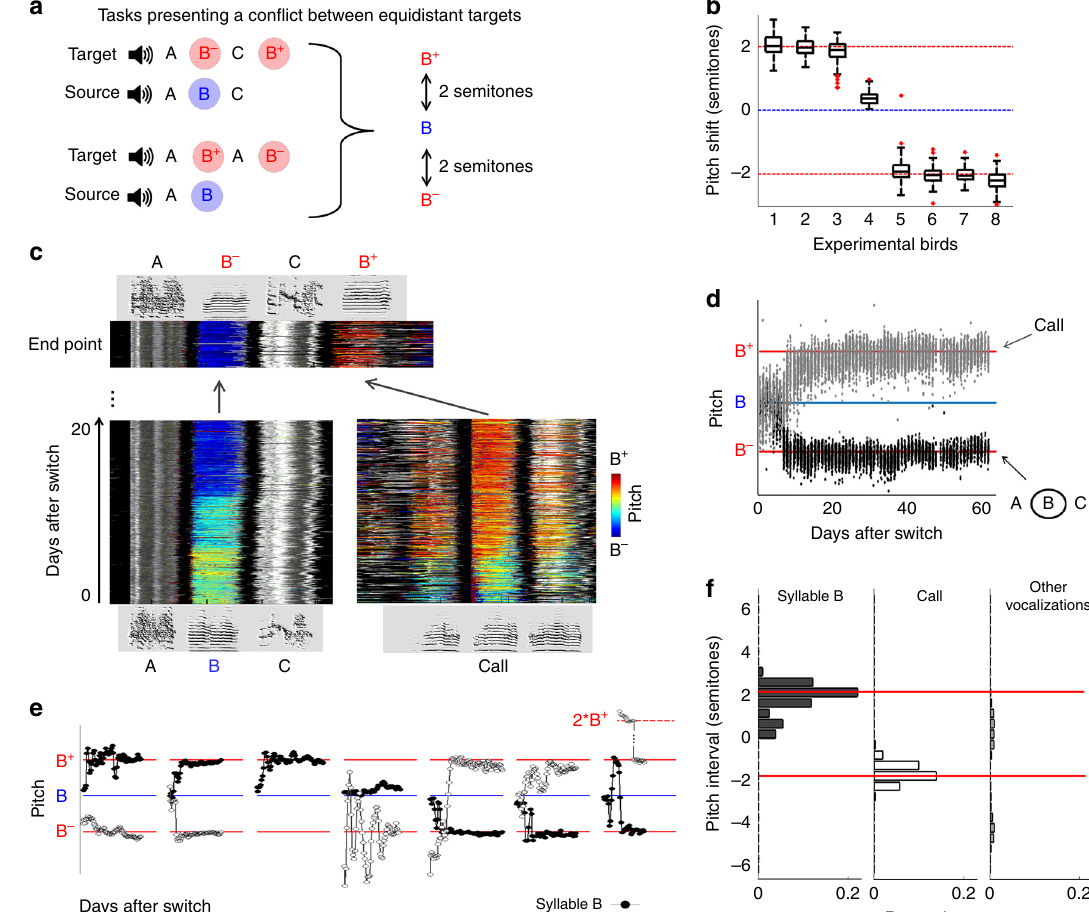
Fig. 5 Competitive error assignment. a Imitation tasks presenting birds with a con fl ict between spectrally equidistant targets: ABC → AB − CB + (imitation task 3, top) and AB → AB + AB − (imitation task 5, bottom). Syllable B in the source songs is presented with the target syllables B − and B + , shifted by 2 semitones down and up respectively. b Boxplots of the pitch shift from source of syllable B renditions on endpoint day, in experimental birds trained with the imitation tasks in a ( n = 4, ABC → AB − CB + n = 4, AB → AB + AB − ). Birds are presented in descending order of median pitch shift. In seven out of eight birds, syllable B closely matched either B − or B + . c Developmental trajectory of an experimental bird trained with ABC → AB − CB + . Stack plots as in Figs. 2 – 4. Syllable B in the song motif shifted down to match target syllable B − (left); in parallel, a call performed outside the song motif differentiated into the missing target B + (right), and got incorporated into the motif (top). d Median pitch in consecutive renditions of syllable B/B − (black), and the call that shifted to B + (gray), during development in the same bird. e Pitch trajectories (daily medians) of all other experimental birds trained with the imitation tasks in a . Black circles, motif syllable B; white circles, a vocalization type (typically a call), which shifted towards the vacant target. f , Left, distribution of the absolute pitch distance from source of renditions originating in motif syllable B on endpoint day (0 = pitch of source syllable B; mean per bin across experimental birds, n = 8); middle and right, same for harmonic vocalizations besides motif syllable B, within 6 semitone distance from source; for each bird, pitch distance is normalized by the direction to which syllable B has shifted: positive values for renditions shifted in the same direction as syllable B, and negative values for renditions shifted in the opposite direction. Across birds, no vocalization converged on the target occupied by the motif syllable. A call converged on the vacant target (middle), while all other vocalizations converged on neither of the targets (right)